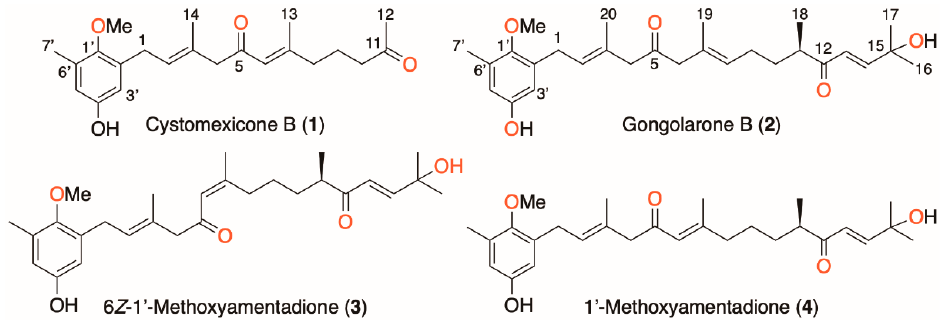
Figure 1. Chemical structure of meroterpenoids isolated from Gongolaria abies-marina